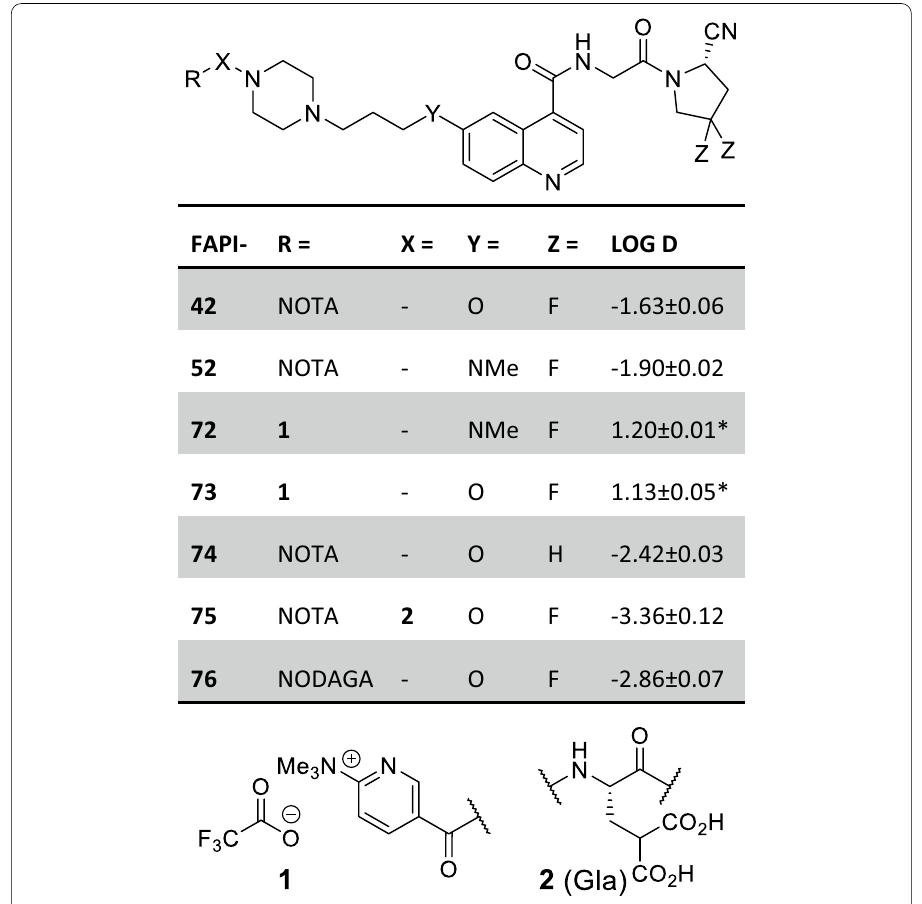
Fig. 1 Overview of the synthesized precursors discussed in this study. The corresponding log D values were determined by detection of the radiolabeled tracer in 1‑octanol and phosphate buffered saline (pH 7). For values labeled with an asterix, the log D was calculated from the relative content of the non‑radioactive reference standards in the 1‑octanol and the water phase by HPLC analysis and peak